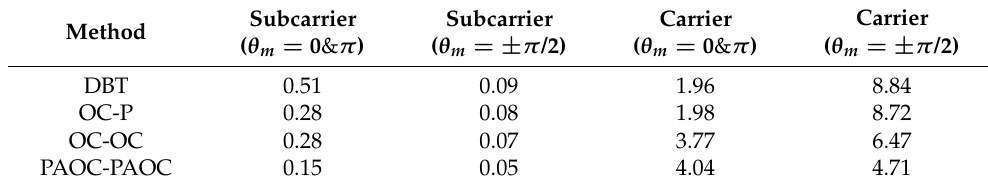
Table 3. Area enclosed by RMSE envelopes of the four methods for the BOC(15, 2.5) signal.